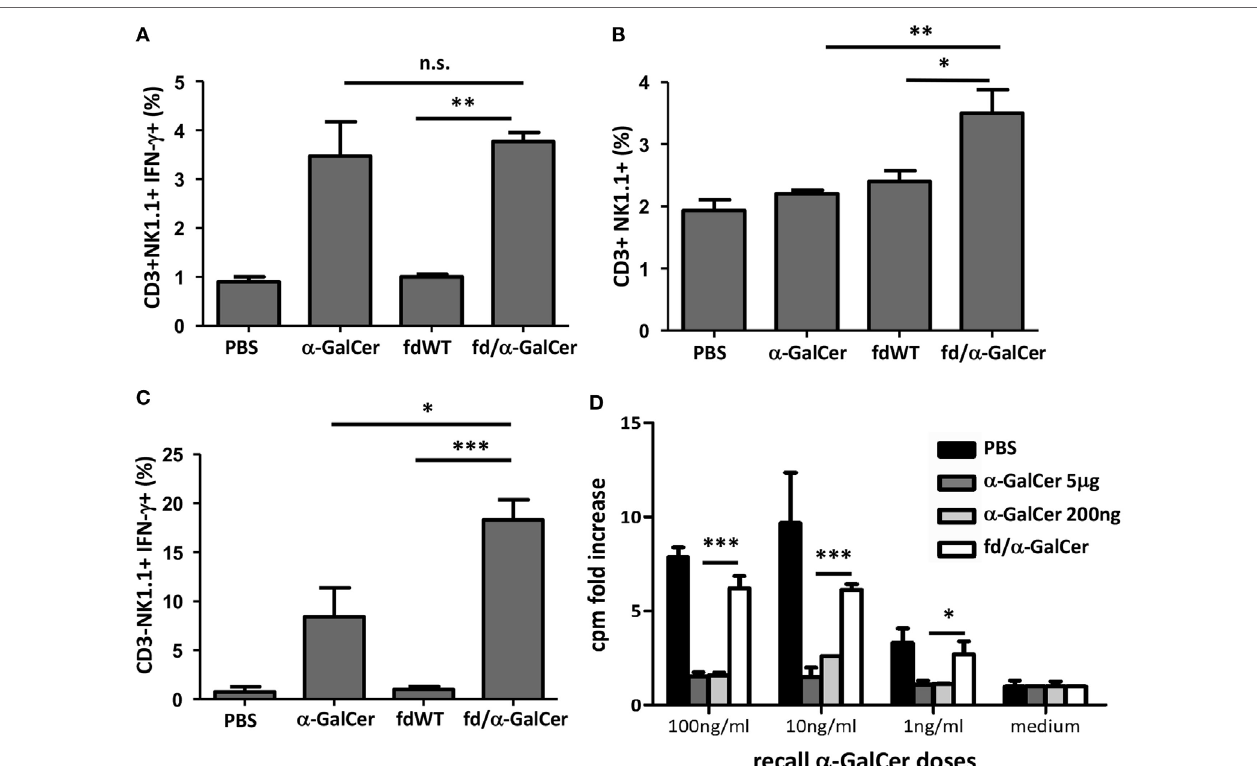
FigUre 2 | In vitro recall response of mice to intravenous alpha-GalactosylCeramide ( α -GalCer) administration. Mice ( n = 3/group) were injected intravenously with 50 µg of fd bacteriophages or 5 µg of free α -GalCer/mouse or vehicle (phosphate buffered saline, PBS). After 3 h, mice were sacrificed, spleen cells were collected and stained with the reported antibodies. (a) Percentage of INF- γ -producing CD3 + NK1.1 + cells; average + SEM is reported. p < 0.001 by one-way analysis of variance (ANOVA) followed by a Dunnett’s multiple comparison test. (B) Percentage of CD3 + NK1.1 + cells 3 h after intravenous injection of above- mentioned reagents. Average + SEM is reported. p < 0.01 by one-way ANOVA followed by a Dunnett’s multiple comparison test. (c) Percentage of INF- γ -producing CD3 − NK1.1 + . Average + SEM is reported. p < 0.001 by one-way ANOVA followed by a Dunnett’s multiple comparison test. * p < 0.05, ** p < 0.01, *** p < 0.001. Abbreviation: ns, not significant. (D) In vitro recall response of mice to α -GalCer immunization. Mice ( n = 3/group) were intravenously injected with 5 µg or 200 ng of free α -GalCer, 50 µg of fd/ α -GalCer or vehicle alone (phosphate buffered saline, PBS). The day after, splenocytes were cultured with graded doses of α -GalCer or medium. After 3 days, proliferation was assessed by [3H] thymidine incorporation. Average + SEM is reported. p < 0.001 by two - way ANOVA and the Bonferroni multiple comparison test. * p < 0.05, ** p < 0.01, *** p <